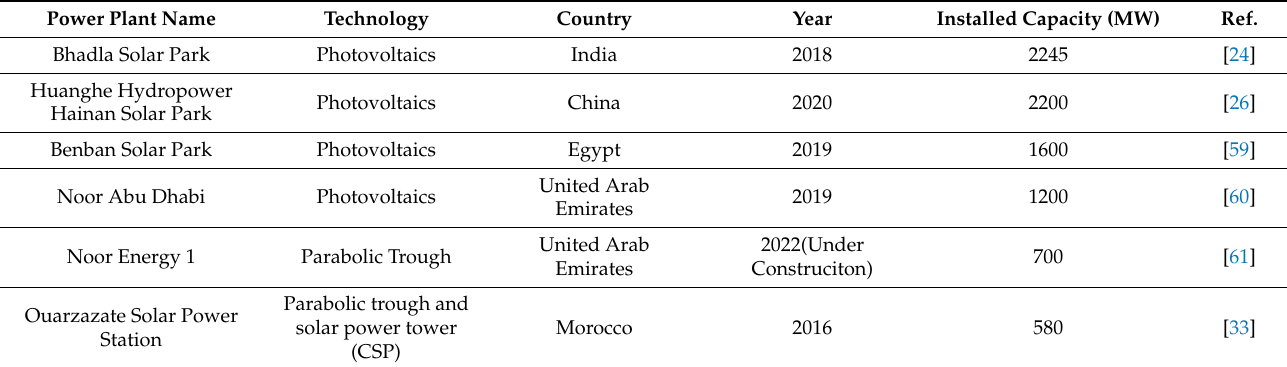
Table 2. Largest Solar Energy Projects Around the